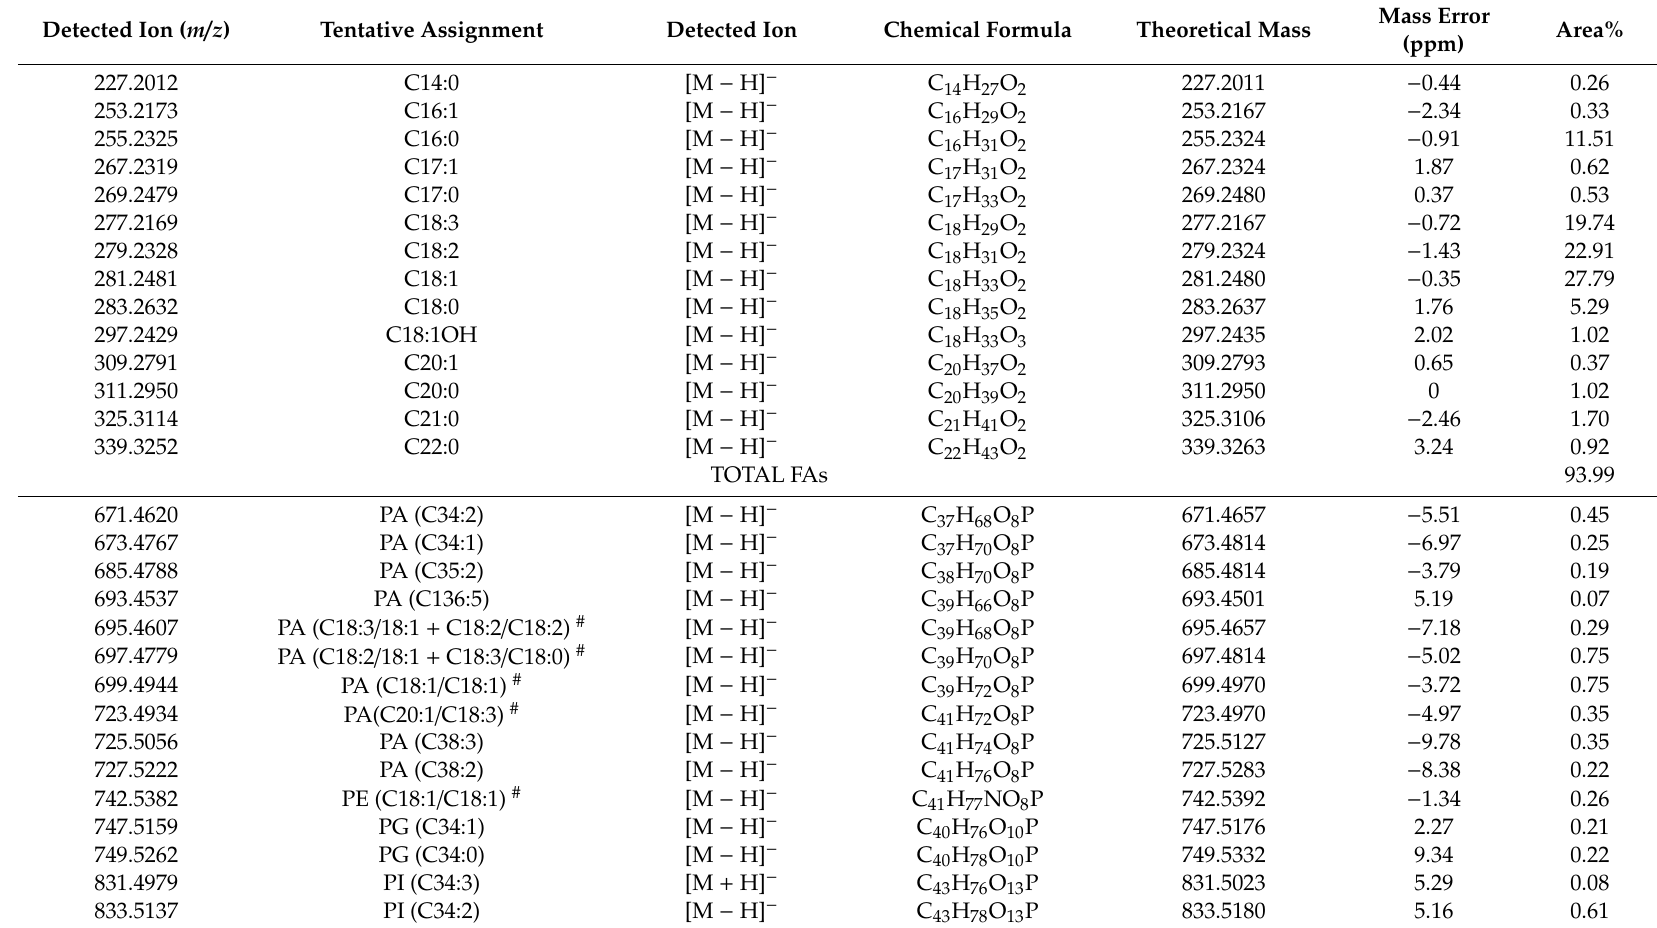
Table 3. Tentative identification of lipid compounds in the fruits of Kigelia africana , along with the kind of detected ion (deprotonated [M − H] − or dehydrated molecule [M + H − H 2 O] + ), its chemical formula and theoretical mass. The mass error (part per million, ppm) for each assignment is also provided. Detected Ion ( m / z